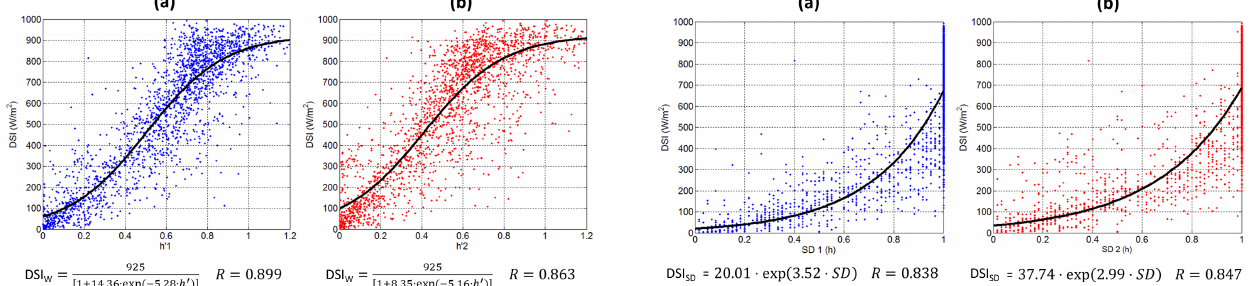
Figure 6. (a) Scatter plots in hourly resolution of the DSI against normalized width for CSSR1. The fitted logistic function and the correlation coefficient are also shown (black line). (b) The same but for CSSR2.